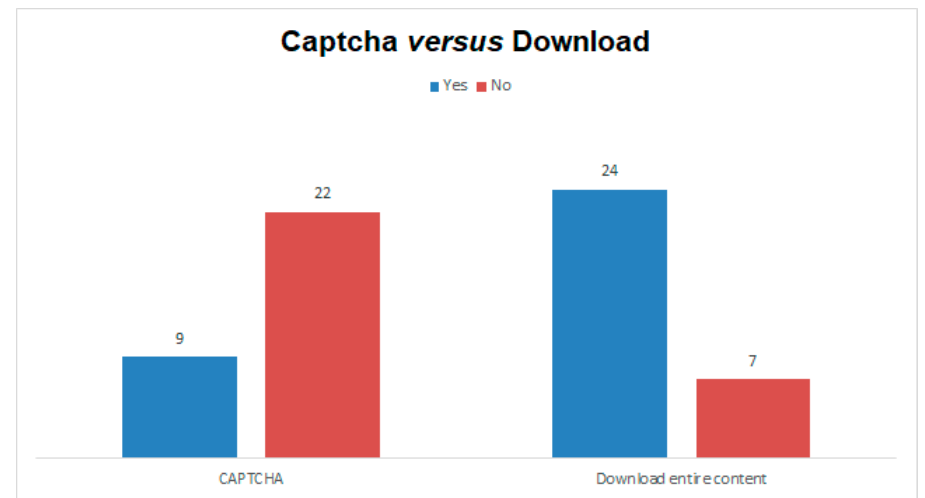
Figure 3. Number of courts using CAPTCHA compared with the number of courts that allows download of the entire content of a case.